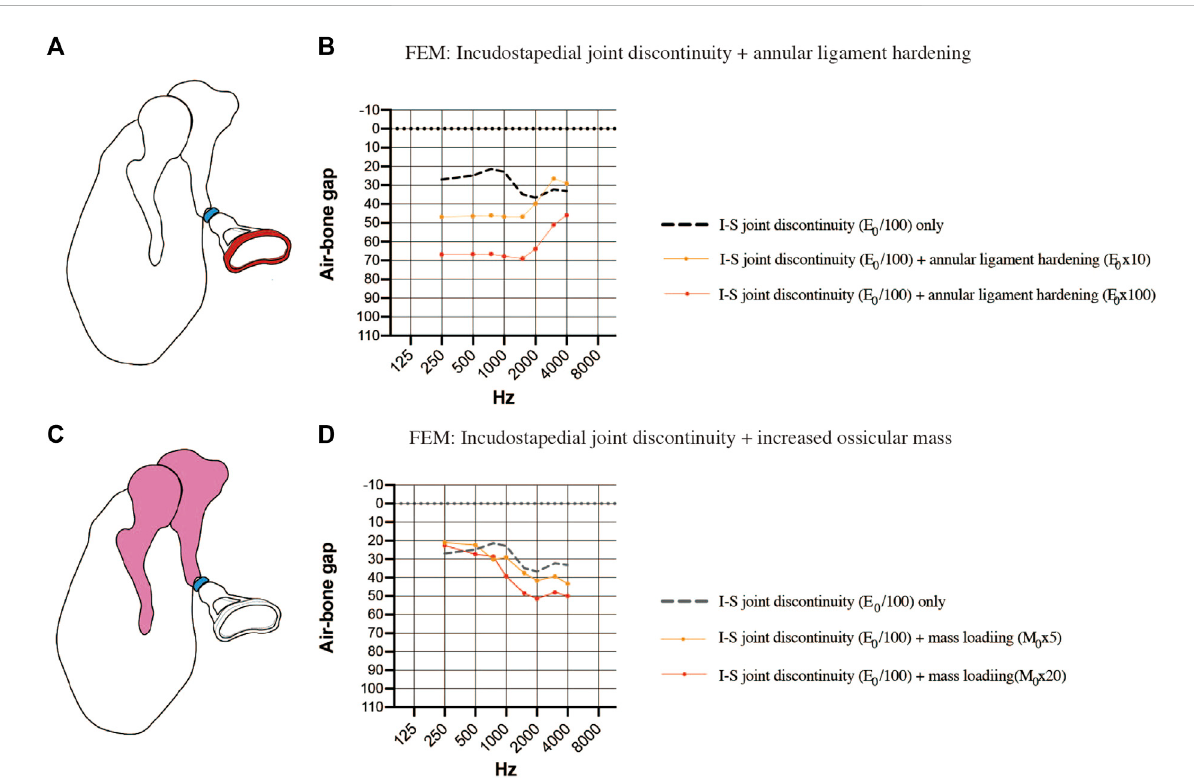
FIGURE 7 Simulated air-bone gaps (ABGs) for complex pathologies. (A) Schematic showing the combination of incudostapedial joint discontinuity and sclerosis of the stapes footplate. (B) Audiogram simulated using the FEM showing the effects of stapes footplate sclerosis (Young ’ s modulus of the annular ligament increased 10-fold or 100-fold; red) superimposed on incudostapedial joint discontinuity (Young ’ s modulus decreased 100-fold; blue). Therewas an additional increase in theABGatfrequencies of 250 – 1500 Hzwhenthe stiffness oftheannular ligament was increased. (C) Schematic showing the combination of incudostapedial joint discontinuity and increased mass of the incus and malleus. (D) Audiogram simulated using the FEM showing the effects of ossicular mass increase (mass of the incus and malleus increased 5-fold or 20-fold; pink) superimposed on incudostapedial joint discontinuity (Young ’ s modulus decreased 100-fold; blue). The ABG was increased when ossicular mass was elevated, but the basic features of the audiogram pattern remained. E 0 : Young ’ s modulus; I-S: incudostapedial joint; M 0 :